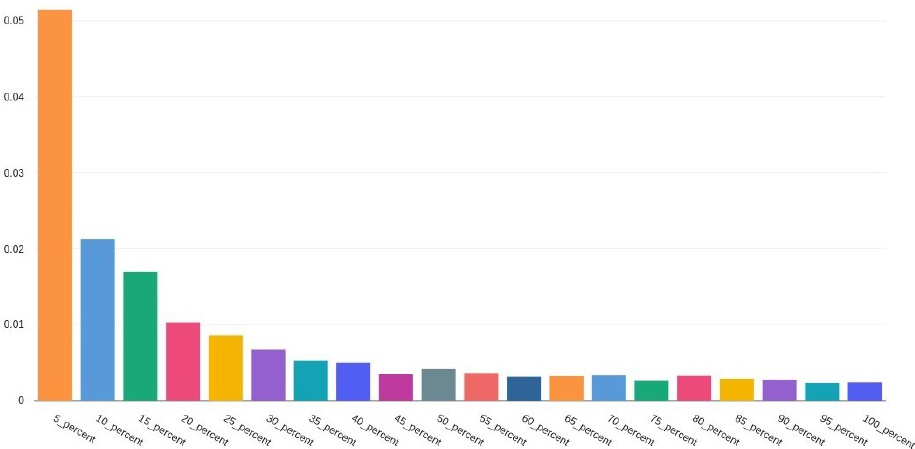
Figure 7. The loss for each percent of the training data used. x -axis is the specified percentage used and y -axis is the loss value.